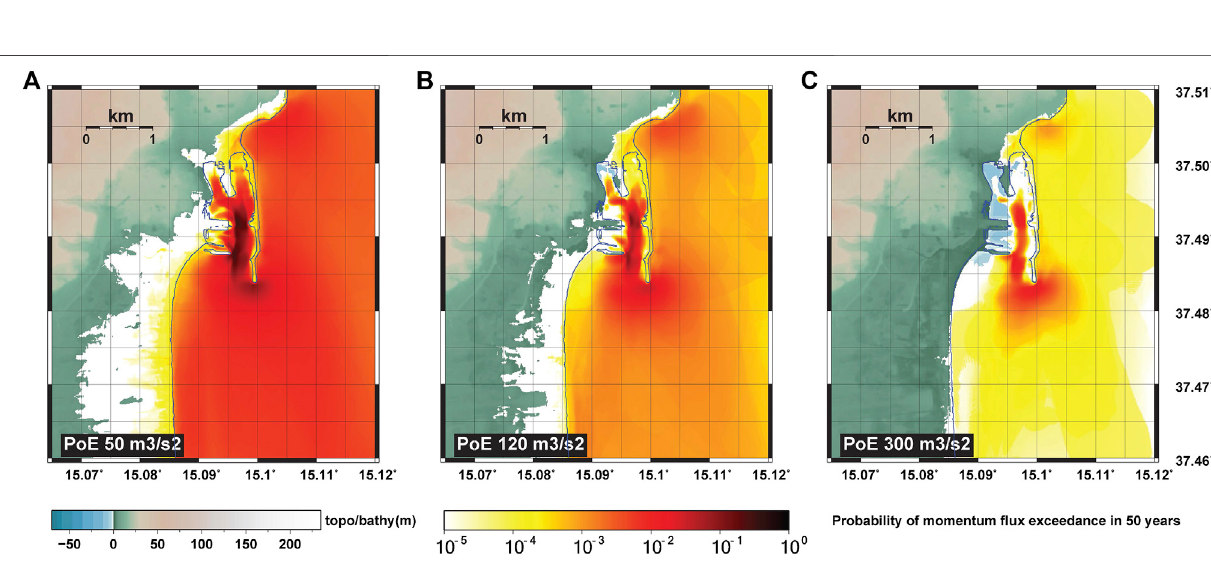
Frontiers in Earth Science |